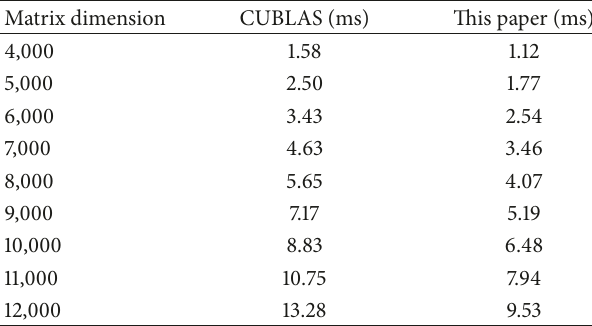
Table 4: Comparison in MVP for square matrix.